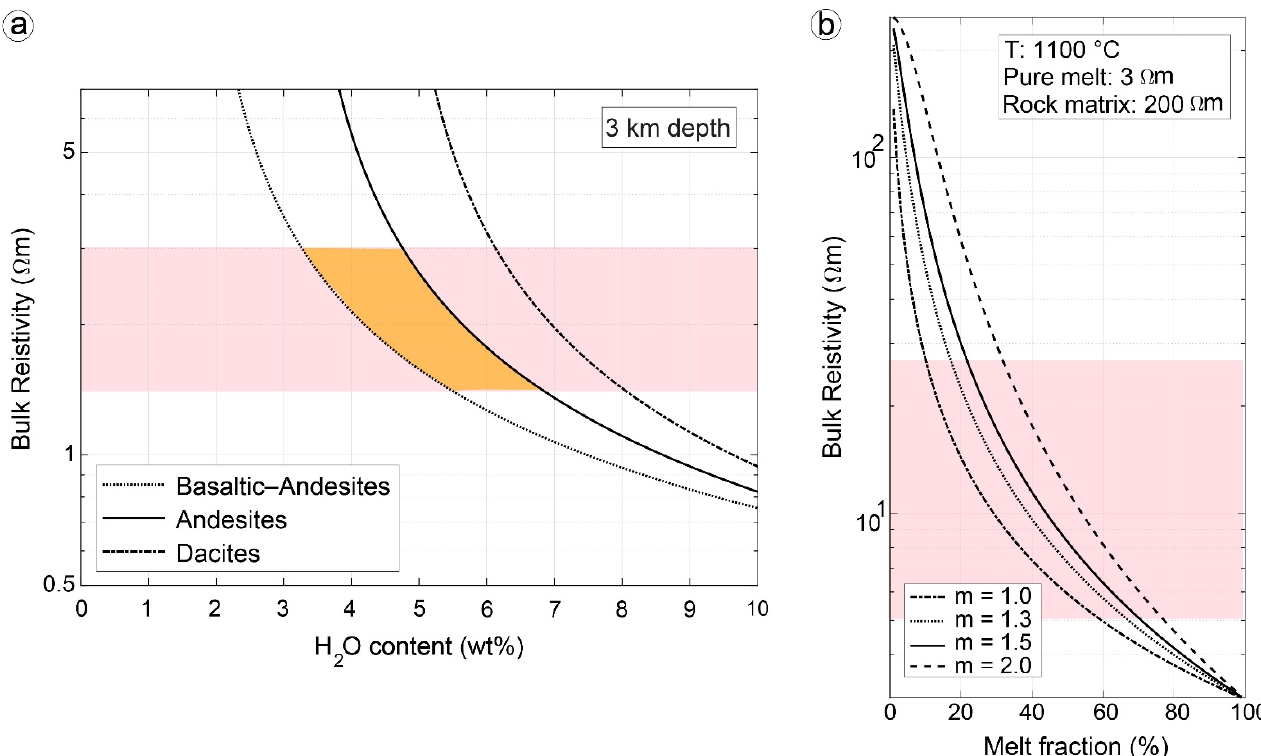
Figure 8. ( a ) Variation of electrical conductivity with water content for different melt compositions, using the models of [65,66]. ( b ) Bulk electrical resistivity of a two-phase system depending on the melt fraction for basalt-andesite melt with a resistivity of 3 Ω m, for different degrees of melt interconnection: Highly interconnected (m = 1.0) and moderately well interconnected (m = 1.5) to isolated (m = 2.0).